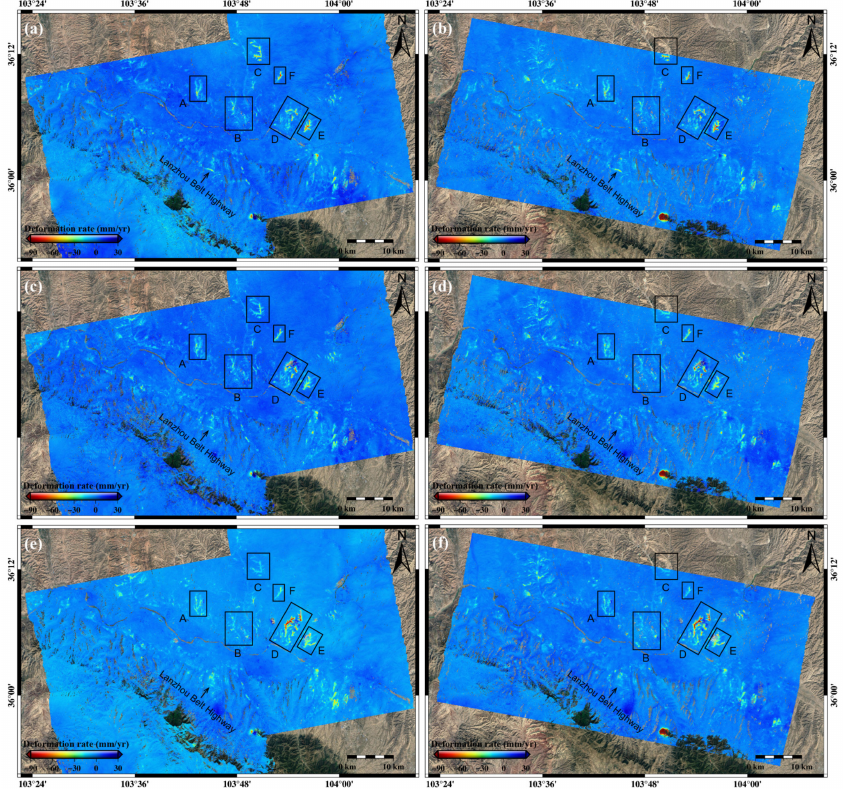
Figure 11. Annual displacement rates generated with ascending and descending Sentinel-1 images for the whole study area. The black rectangles (i.e., A, B, C, D, E and F) indicate six obvious land subsidence regions with relatively large area. ( a ) The displacement rate derived from ascending Sentinel-1 images between 15 December 2015 and 28 December 2017; ( b ) the displacement rate derived from descending Sentinel-1 images between 8 December 2015 and 21 December 2017; ( c ) the displacement rate derived from ascending Sentinel-1 images between 28 December 2017 and 30 December 2019; ( d ) the displacement rate derived from descending Sentinel-1 images between 21 December 2017 and 23 December 2019; ( e ) the displacement rate derived from ascending Sentinel-1 images between 30 December 2019 and 30 March 2021; and ( f ) the displacement rate derived from descending Sentinel-1 images between 23 December 2019 and 23 March